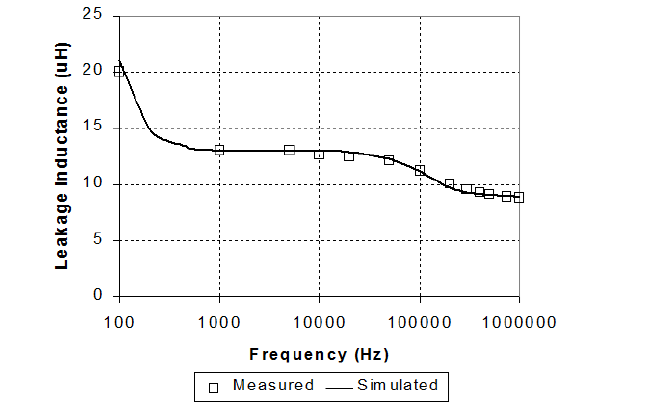
Figure 14: Measured and Simulated leakage Inductance for RM12